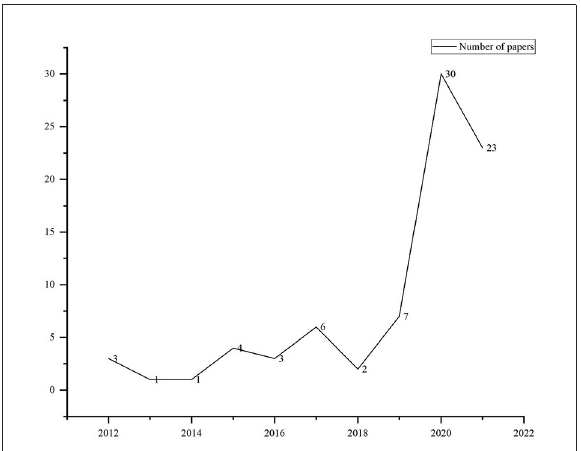
FIGURE2 Annual distribution of empirical literature on VR applications in higher education.